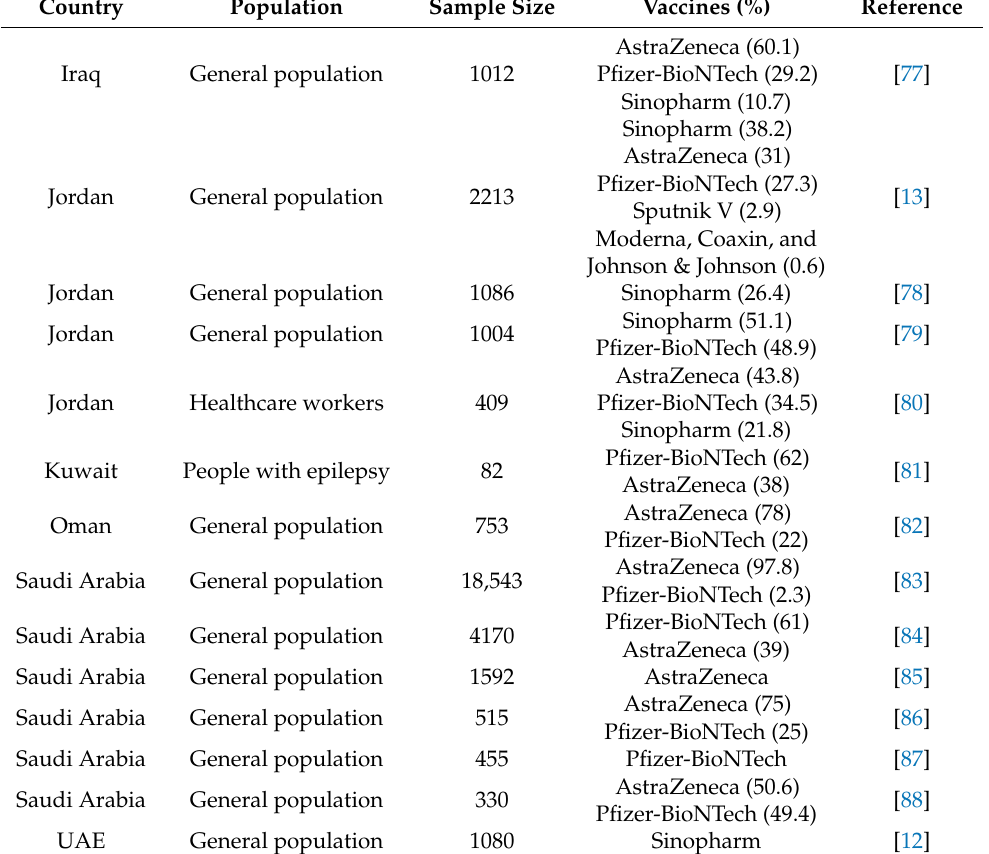
Table 9. List of studies on the side effects following COVID-19 vaccination in Arab